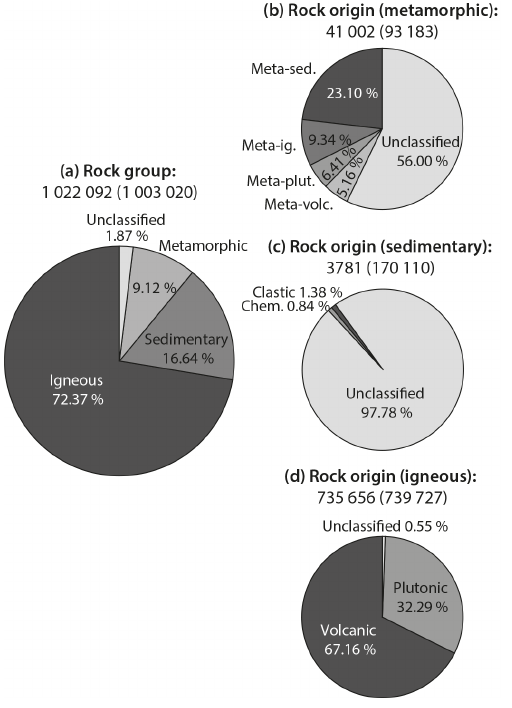
bution of samples containing a rock group. (b–d) denote the rock origin distributions of the rock group fields where rock origin is